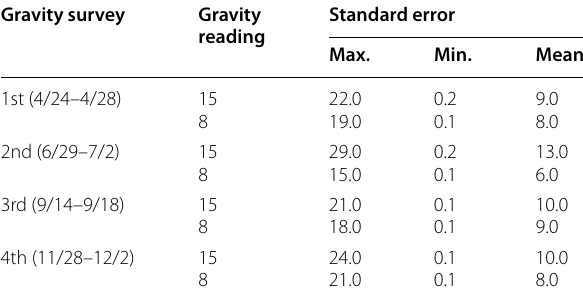
Table 1 Standard errors of the RG gravity measurements (in μGal) from all 15 readings and from the 8 selected readings Gravity